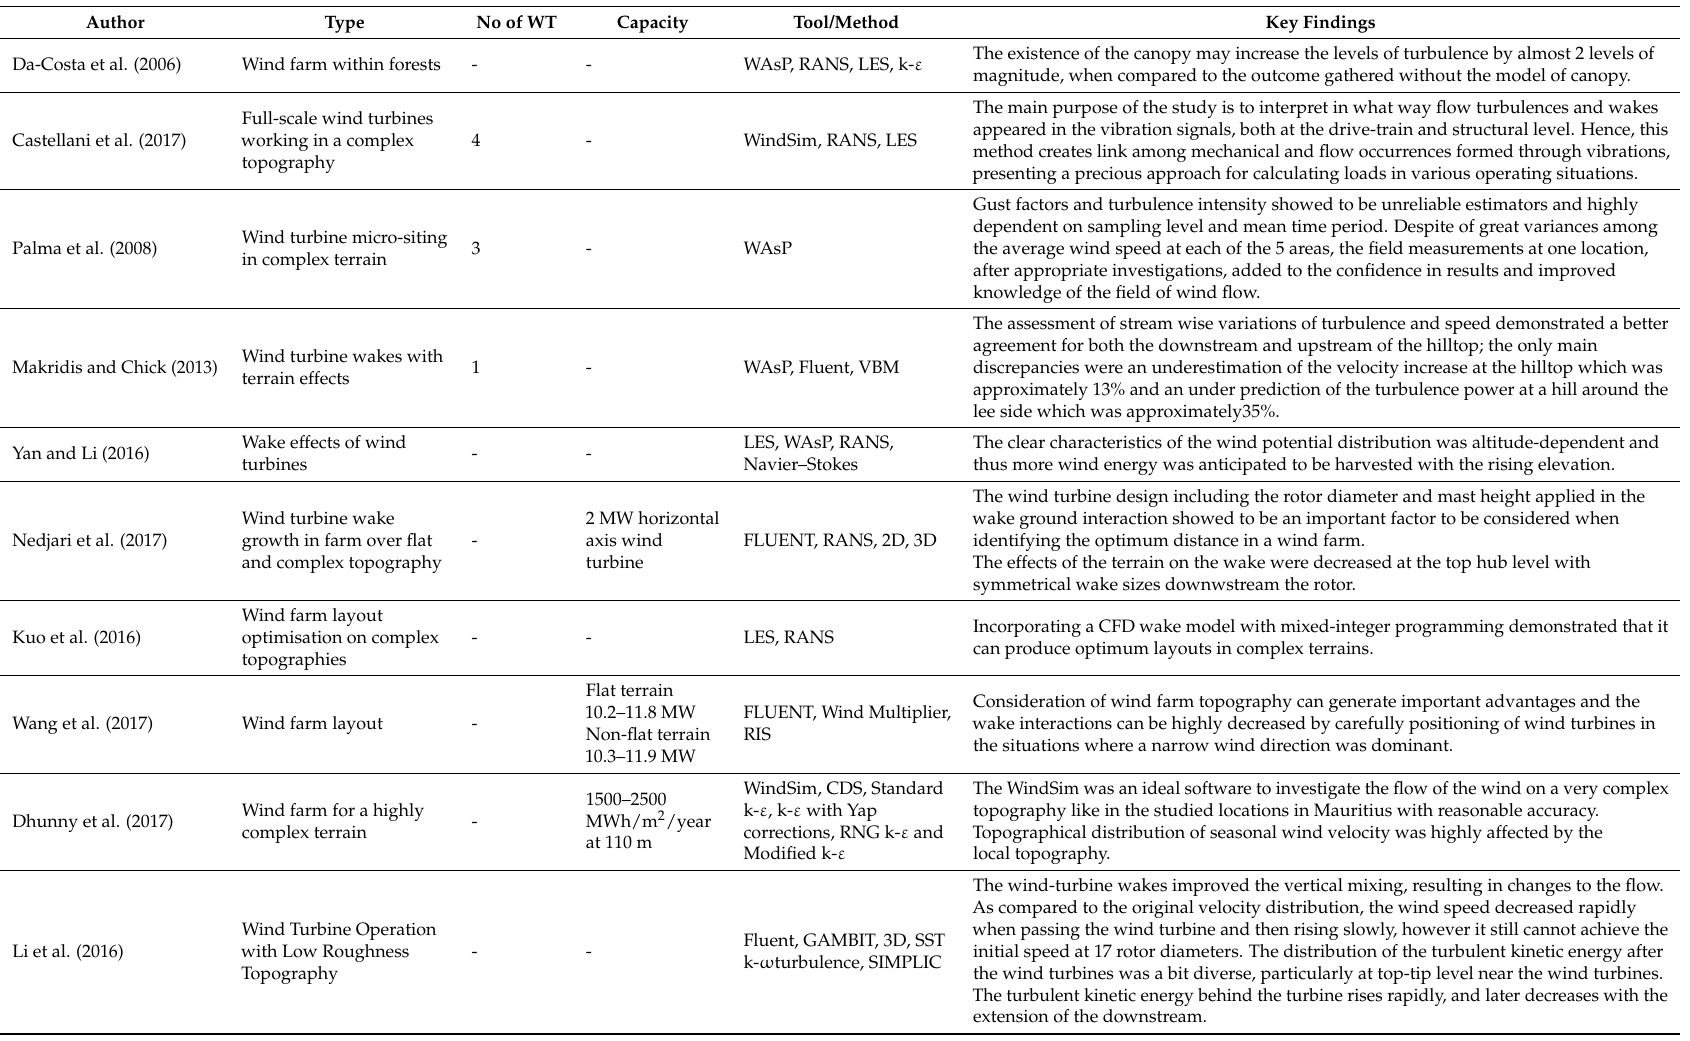
Table 3. Wind Turbine Assessment—Large Scale Wind